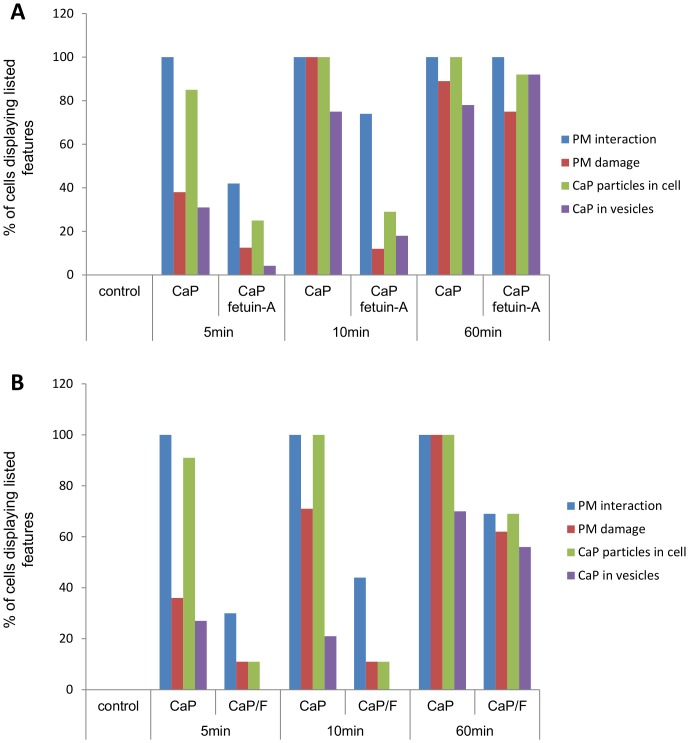
TEM analysis of CaP particle/VSMC interactions in the presence of fetuin-A.A. Images taken at random (see Figure 6) were assessed for various features including: VSMC plasma membrane interaction; plasma membrane damage; CaP particles seen within cells and CaP particles seen within discrete intracellular compartments (vesicles) (n ≥9 for each condition/time point). Controls were samples exposed to serum-free physiological buffer without particles. A clear trend was observed where the presence of fetuin-A reduced CaP interactions with cells up to 10 minutes of exposure. However, the presence of fetuin-A did not appear to influence CaP interactions/uptake after 60 minutes of exposure. B. As for A, but the effect of CaP particles on VSMC interactions/uptake was compared with CaP/F (n ≥9). As for fetuin-A added in solution (A), the presence of fetuin-A on CaP particles appeared to delay early interactions with VSMC.